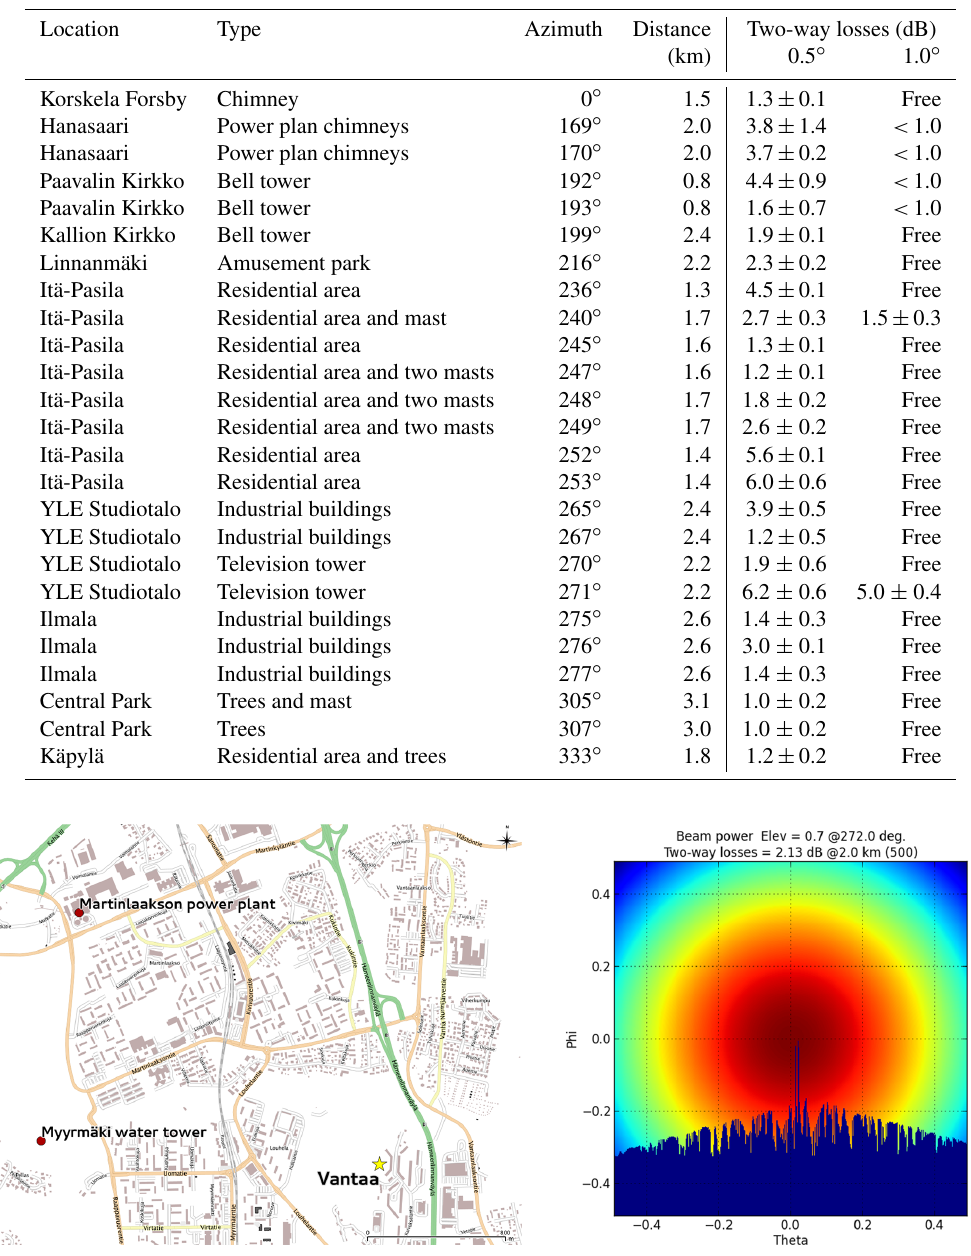
Table 2. Kumpula weather radar partial beam blockages estimated from ALS data.